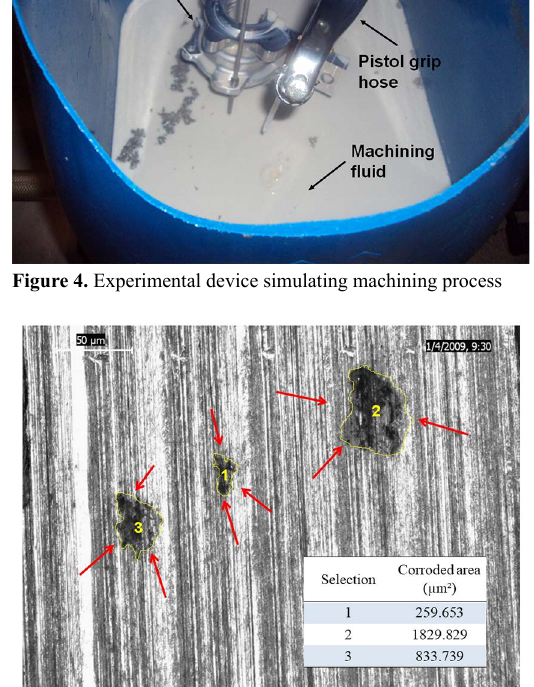
Table 1. Controlling factors and their low and high levels for machining step Factor